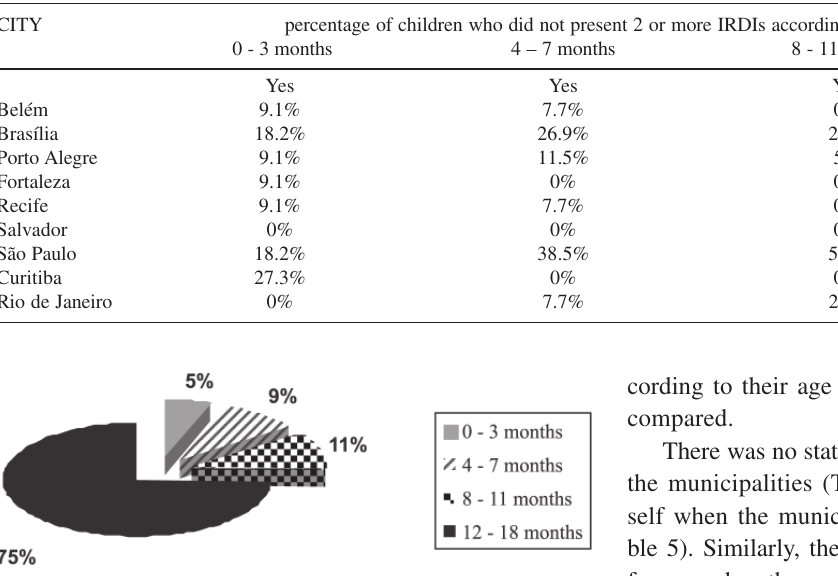
Figure 3 - Distribution of the total number of children participating in this multicenter study according to their age